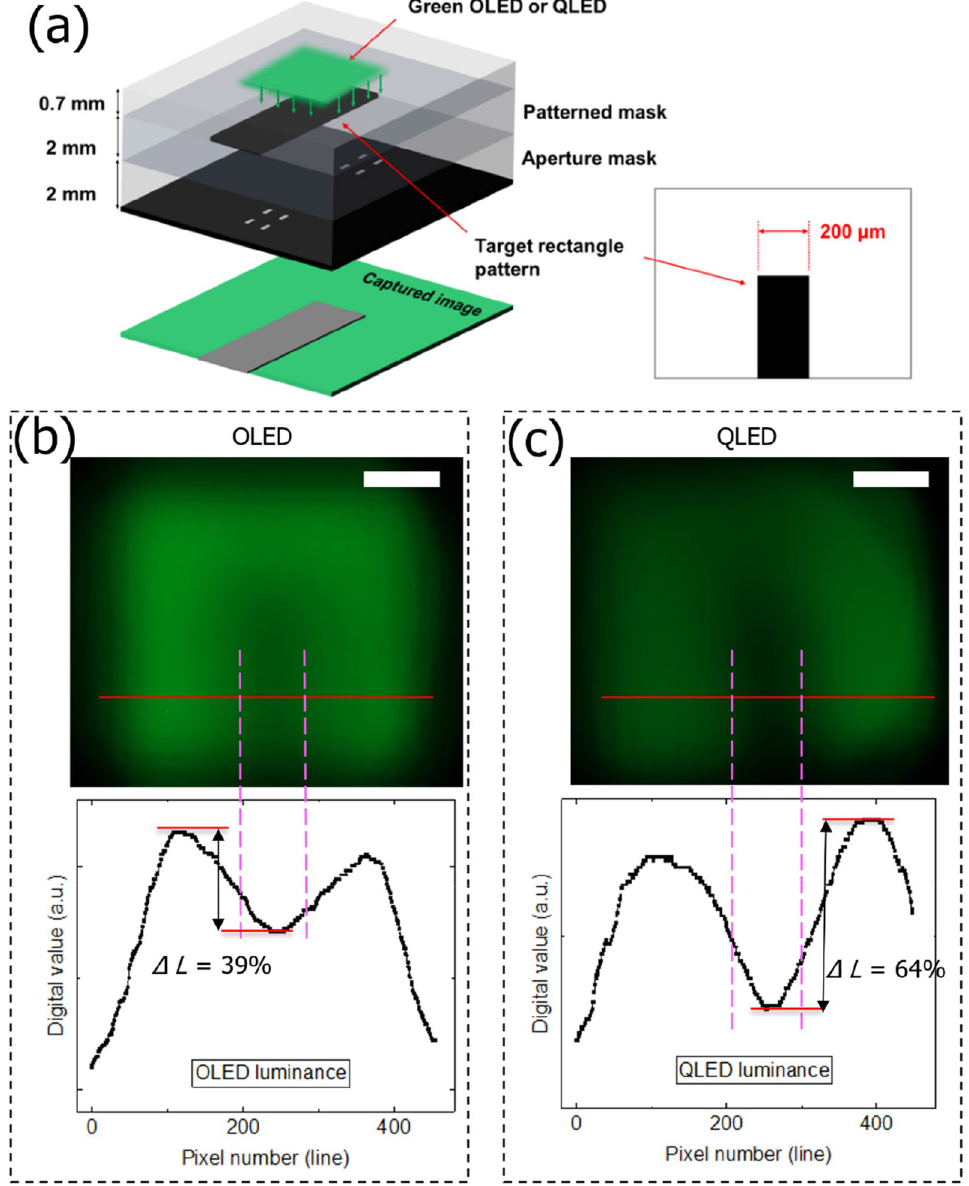
Figure 5. Blurred degree of the pattern in OLED and QLED green spectra. ( a ) Device structure with eight 10 µm × 10 µm apertures for direct illumination under OLED or QLED green light. ( b ) OLED and ( c ) QLED green light image under direct display pixel irradiation, scale bar: 200 µm. Cross-sectional digital line luminance values of the captured images of OLED and QLED green